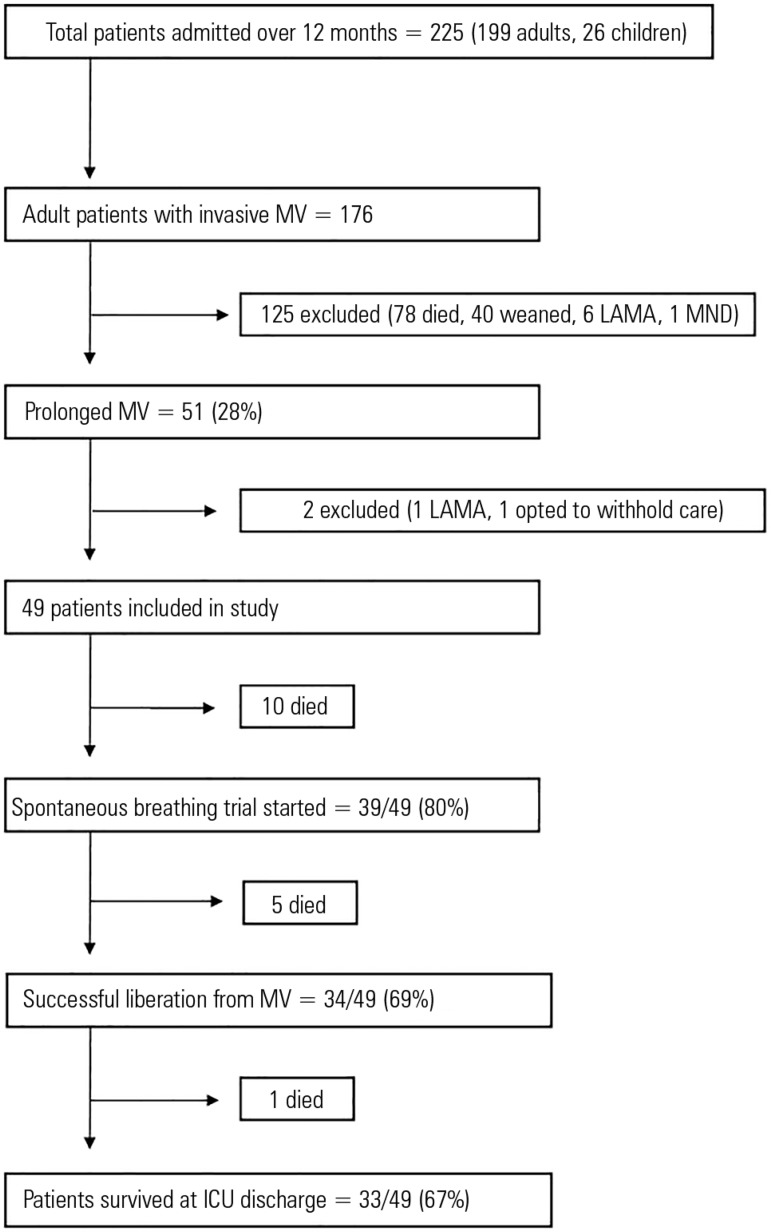
Study flow chart for patients with prolonged mechanical ventilation.MV - mechanical ventilation; LAMA - left against medical advice; MND -
motor neuron disease; ICU - intensive care unit.